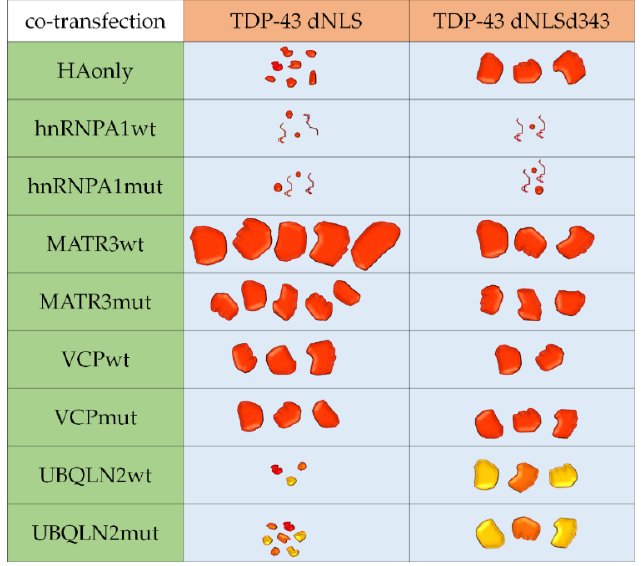
Figure 6. Summary of TDP-43 aggregation strains in co-transfected SH-SY5Y cells. Full red shapes represent TDP-43 aggregates, twisted lines represent soluble TDP-43, and orange and yellow shapes represent TDP-43 aggregates co-localized with UBQLN2.